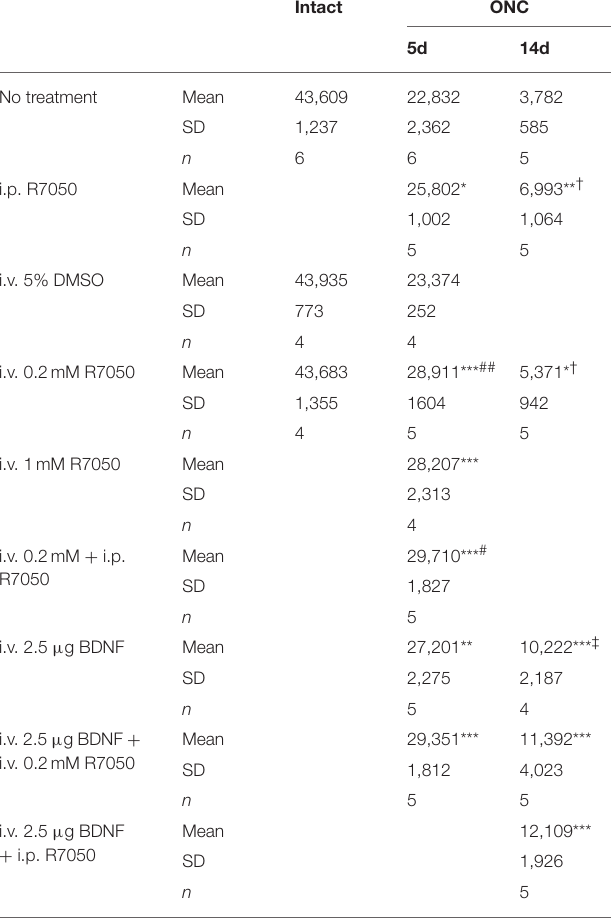
TABLE 1 | Total number of RGCs.